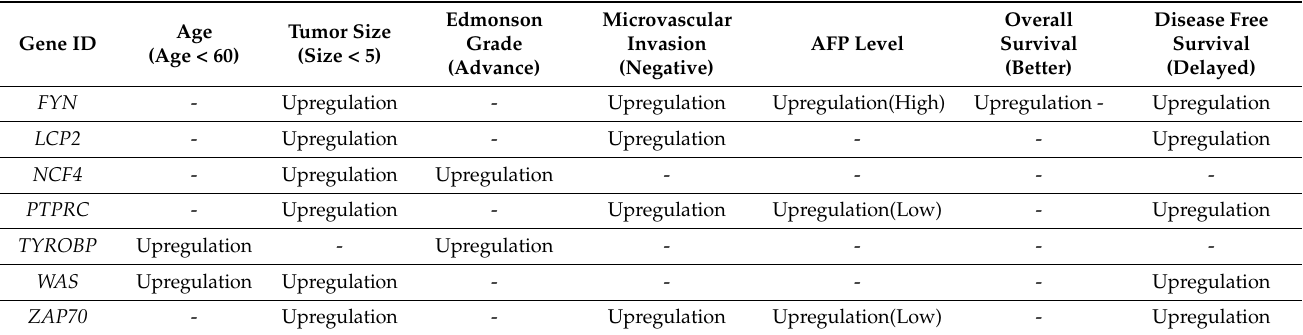
Table 1. Association of expression of 7 genes signature with clinical features in Discovery cohort.